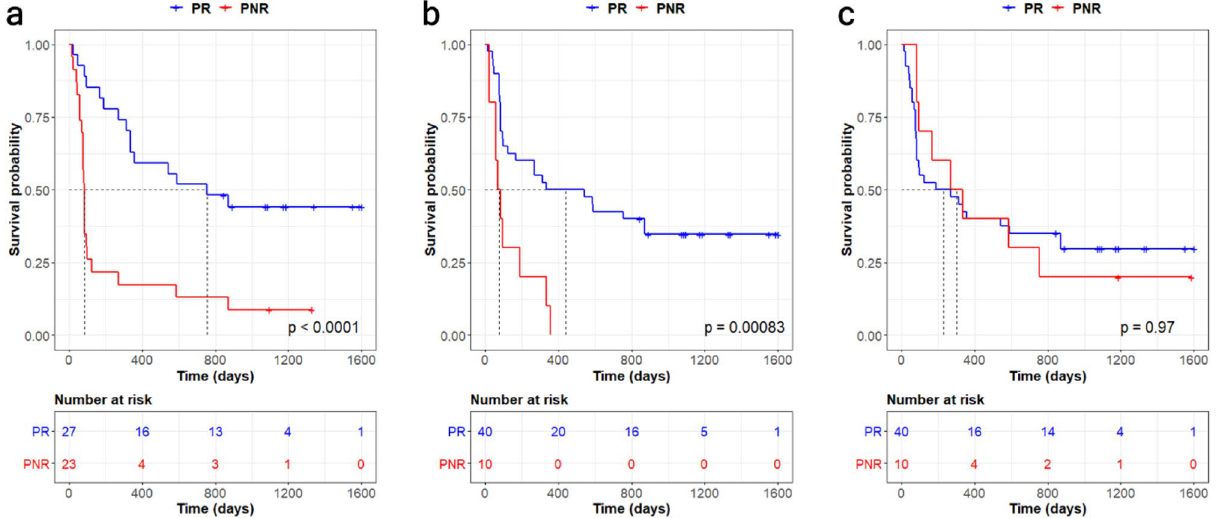
Figure 3. Kaplan–Meier plots of progression-free survival for predicted responder (PR) and non-responder (PNR) patients determined by three classifiers. ( a ) Generalized SVM classifier with DeepBioGen augmentations. ( b ) IMPRES. ( c ) TIDE.